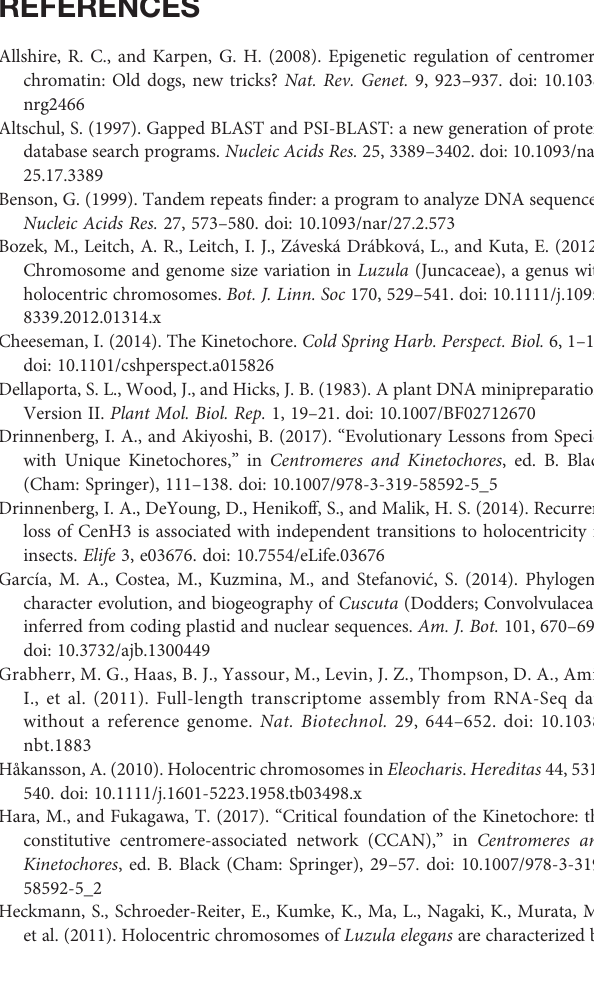
SUPPLEMENTARY TABLE 2 | Proportions of major types of repetitive DNA in the genome of C. europaea . SUPPLEMENTARY DATA S1 | Sequences of the FISH probes in FASTA